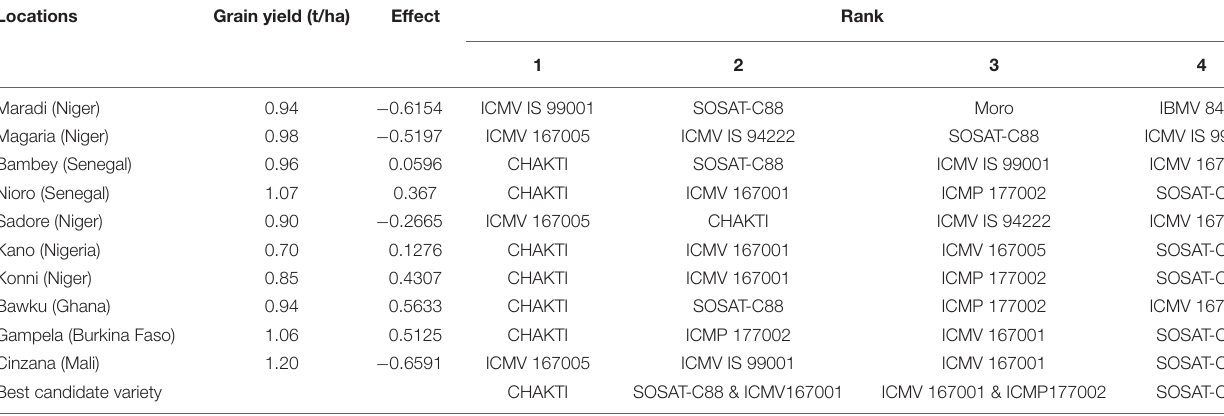
TABLE 5 | First four AMMI selections based on best grain yielding genotypes in each environment. Locations